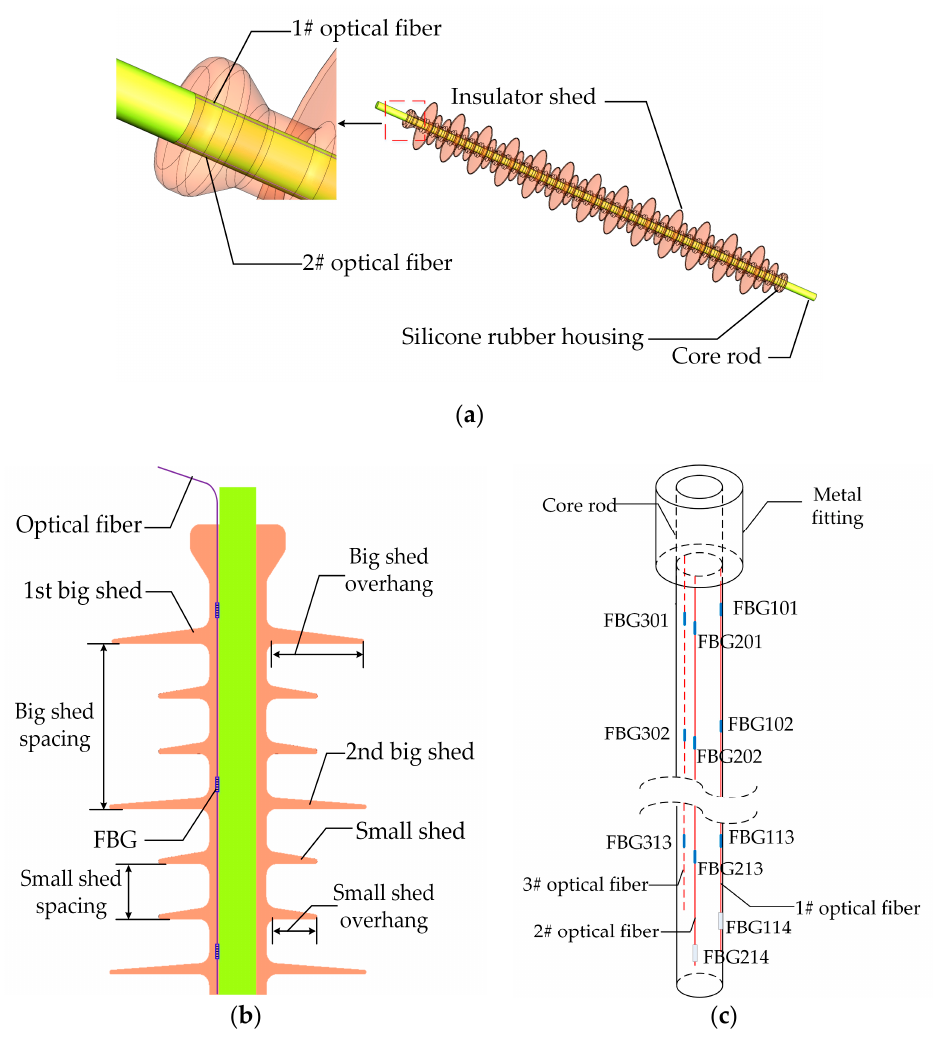
Figure 2. Diagram of a 110 kV composite insulator with embedded FBGs. ( a ) The parts of a composite insulator with embedded FBGs; ( b ) Relative positions between FBGs and insulator sheds; ( c ) Distribution diagram of three optical fibers with FBGs.